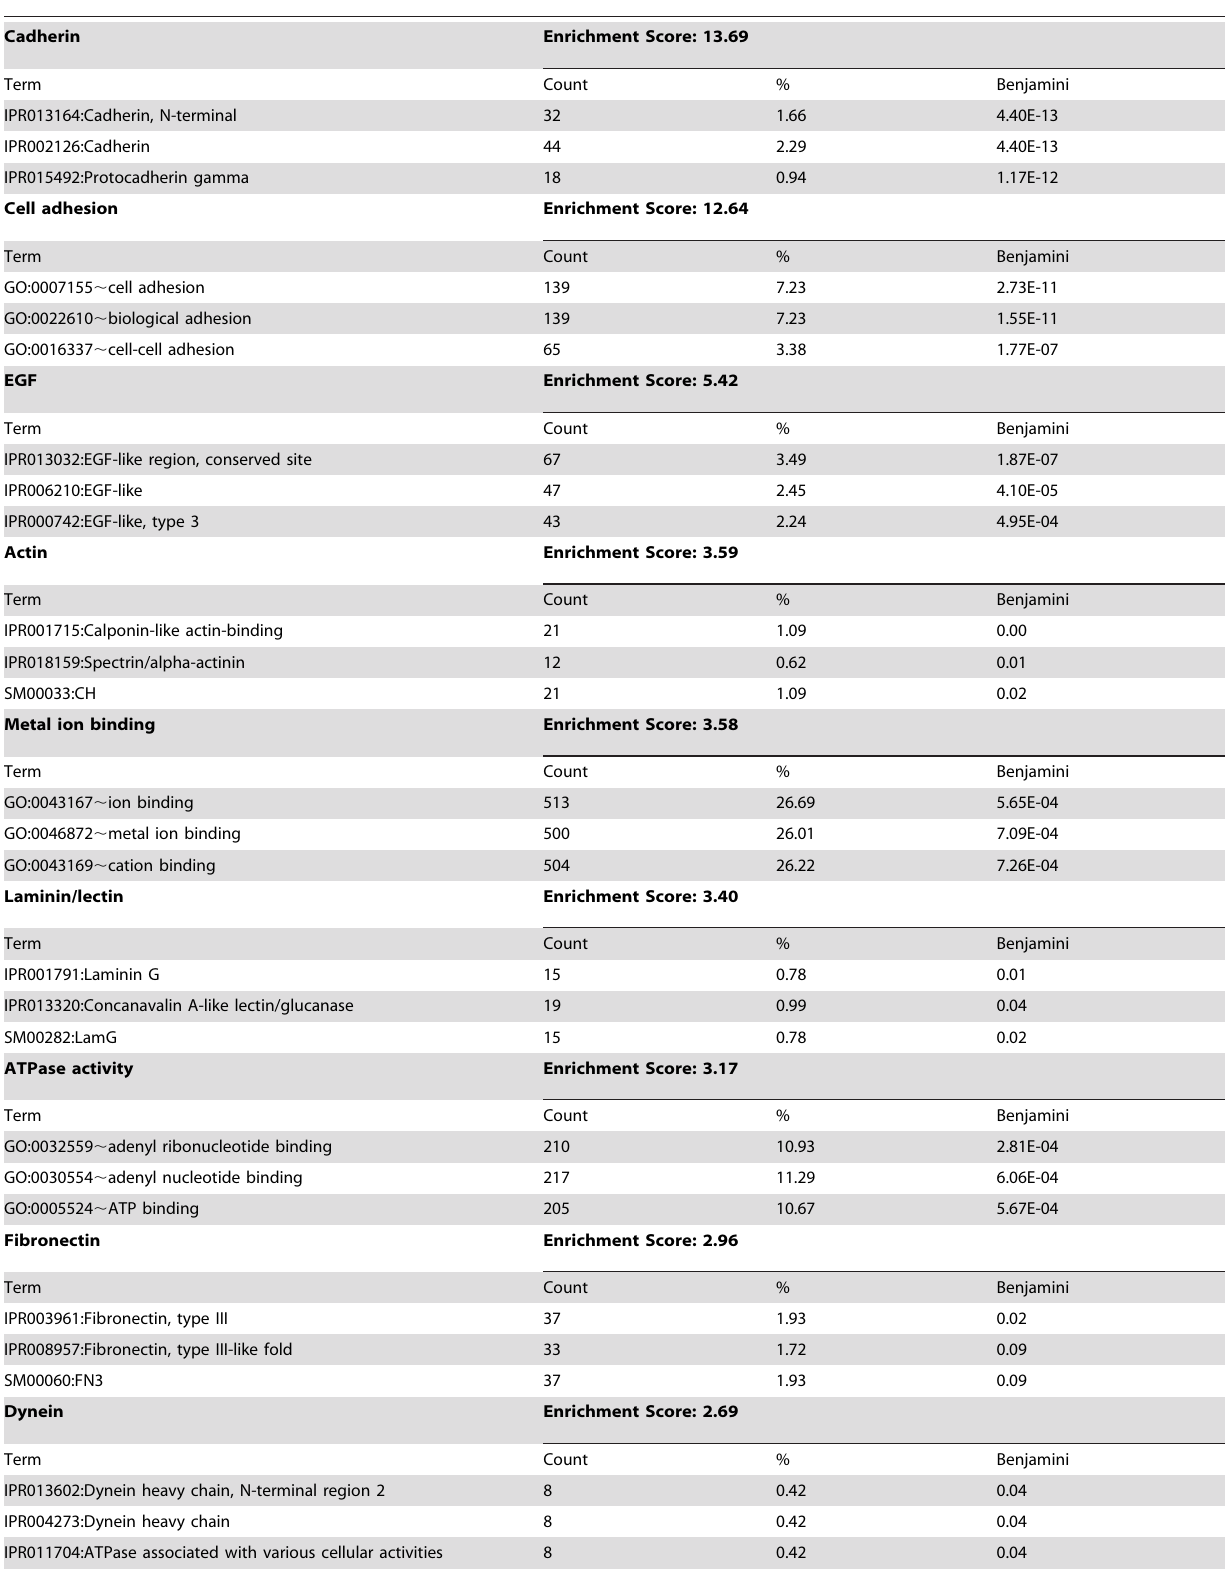
Table 2. Top 10 clusters ranked by enrichment score from GSEA results.